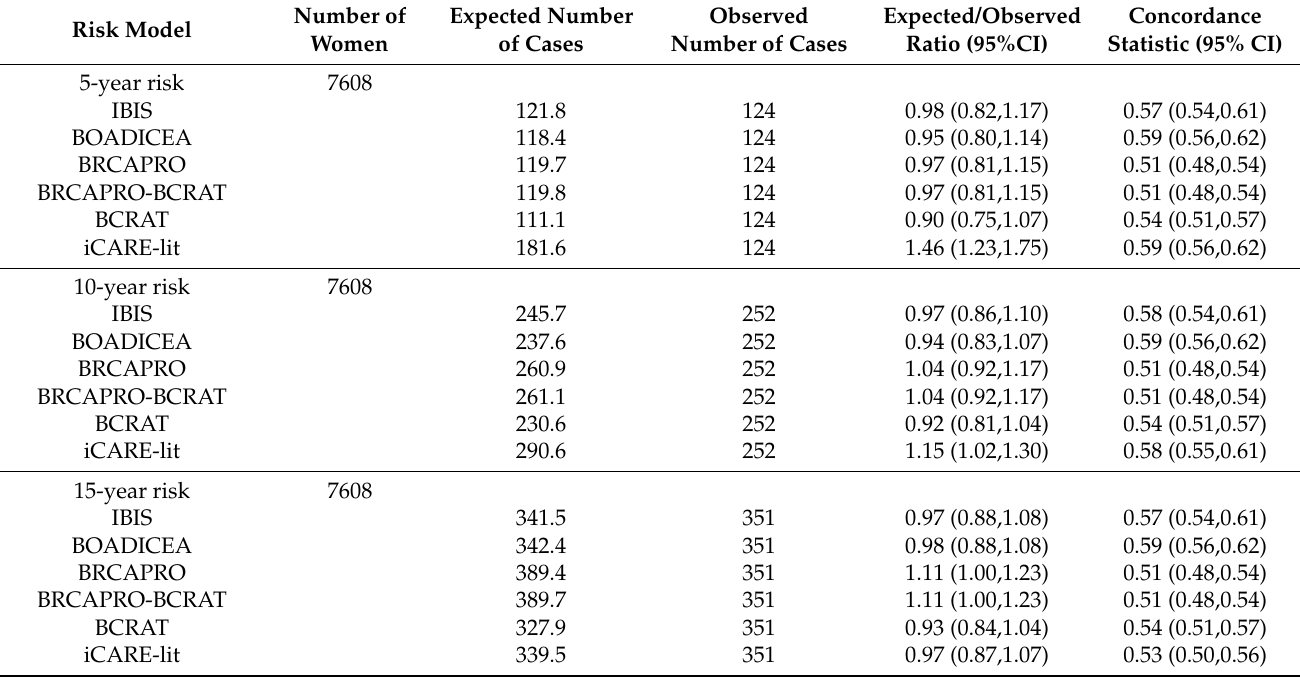
Table 3. Calibration and discrimination statistics for 5-year, 10-year, and 15-year